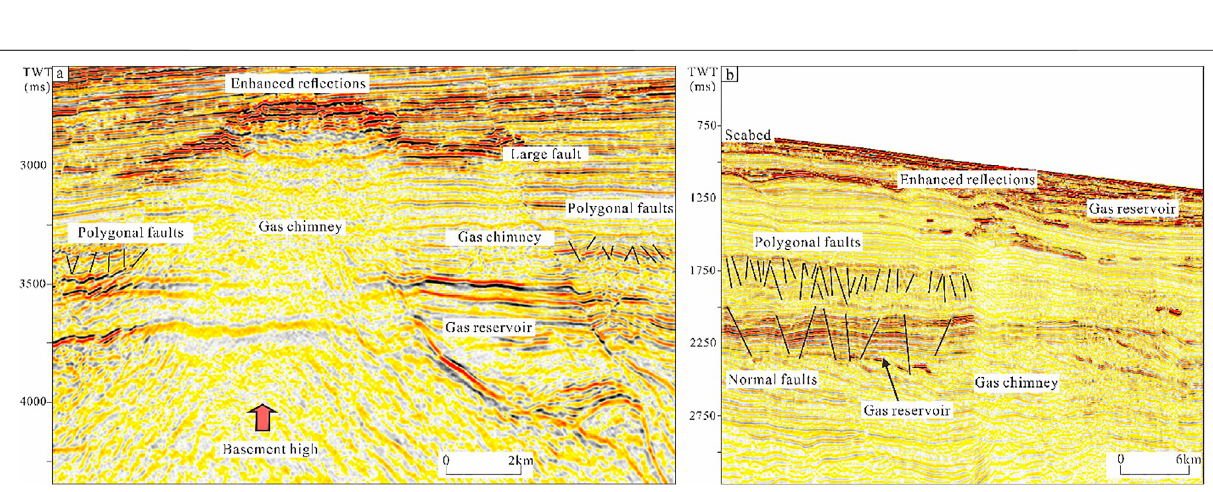
Frontiers in Earth Science |